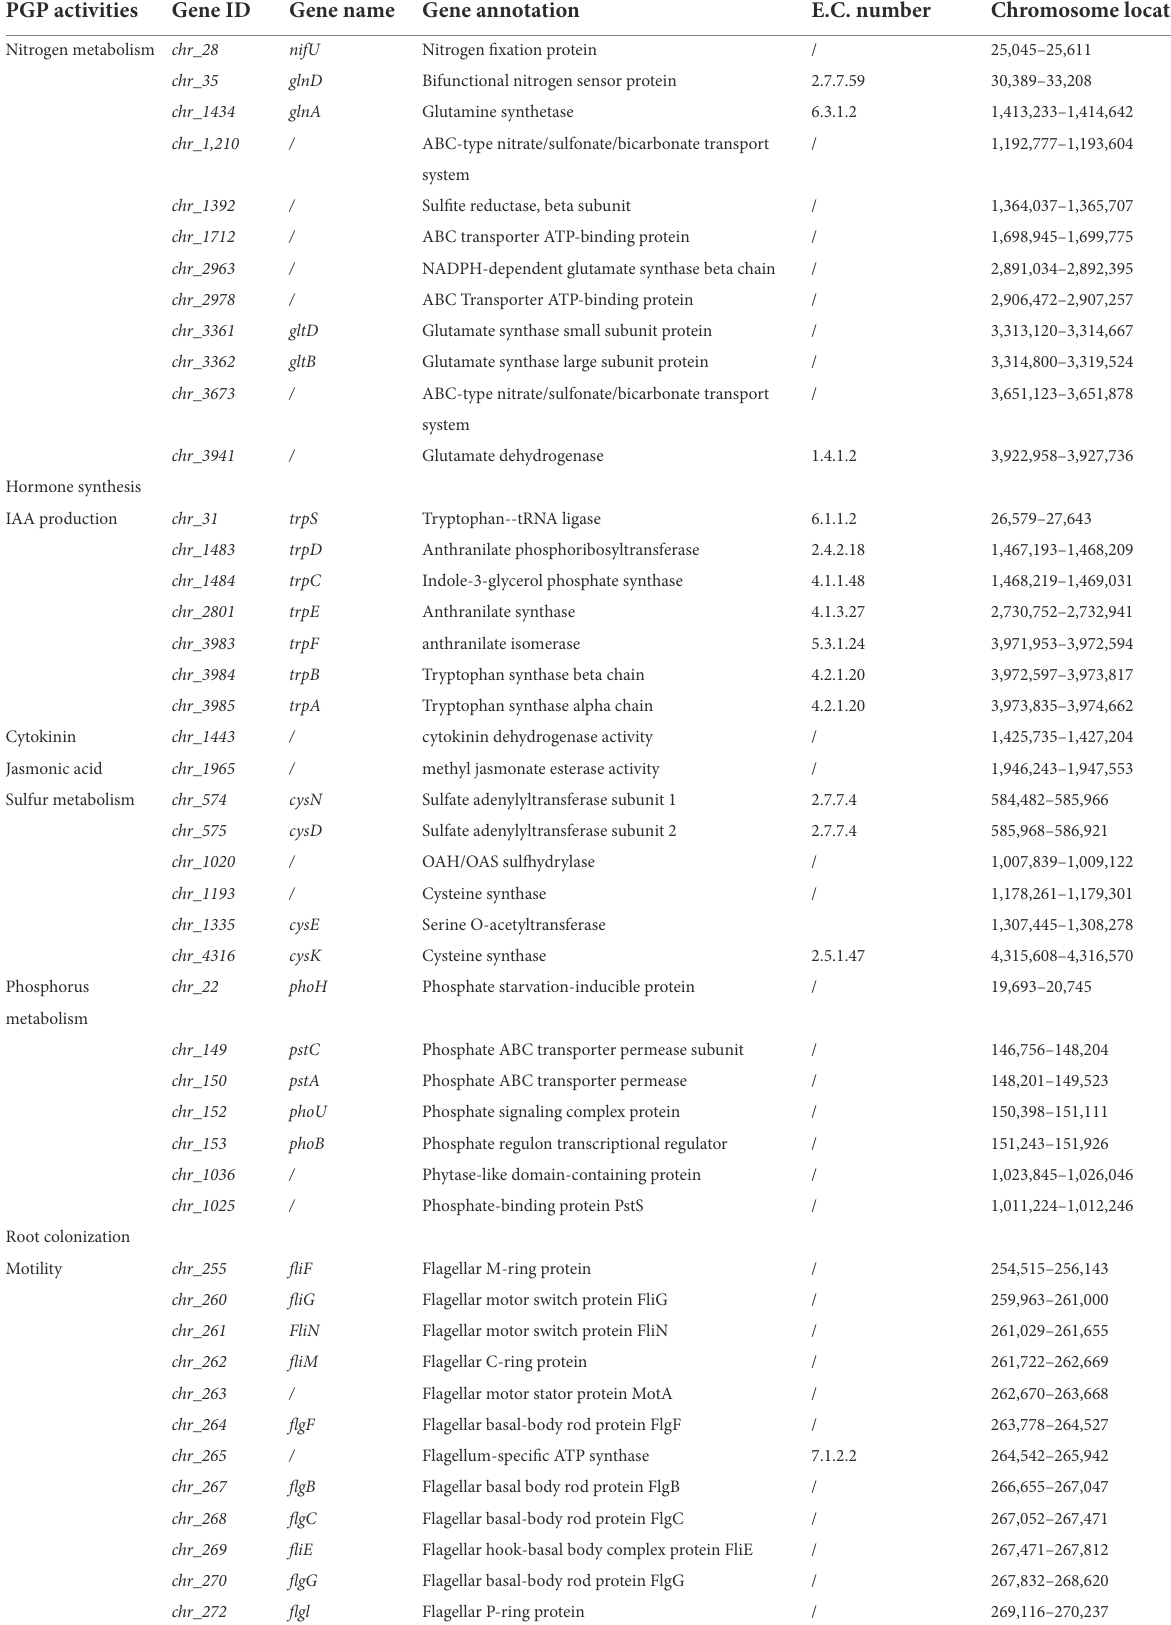
TABLE 4 Genes associated with plant growth promoting traits in Rhizobium sp. WYJ-E13